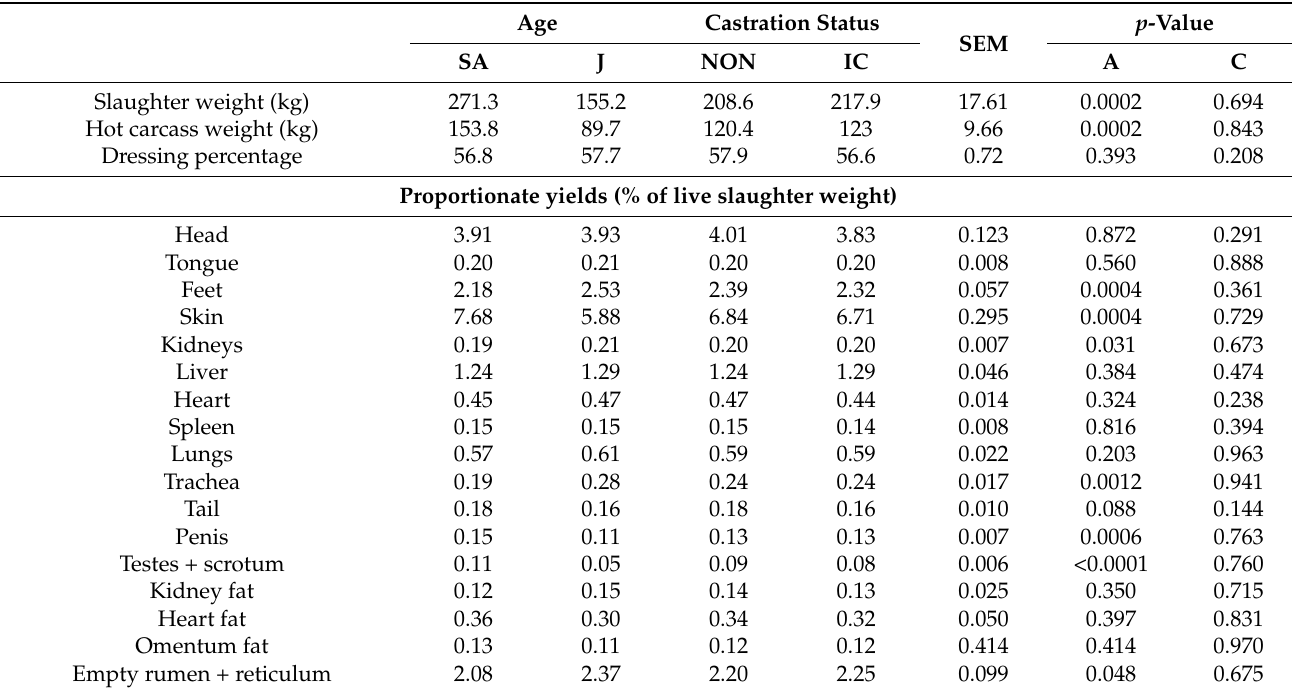
Table 1. Effect of age and castration on slaughter performance and offal yields of farmed common eland males. Significant differences are reported for the main effects, as no interactions ( p > 0.05) between main effects were found. p Age Castration Status SEM